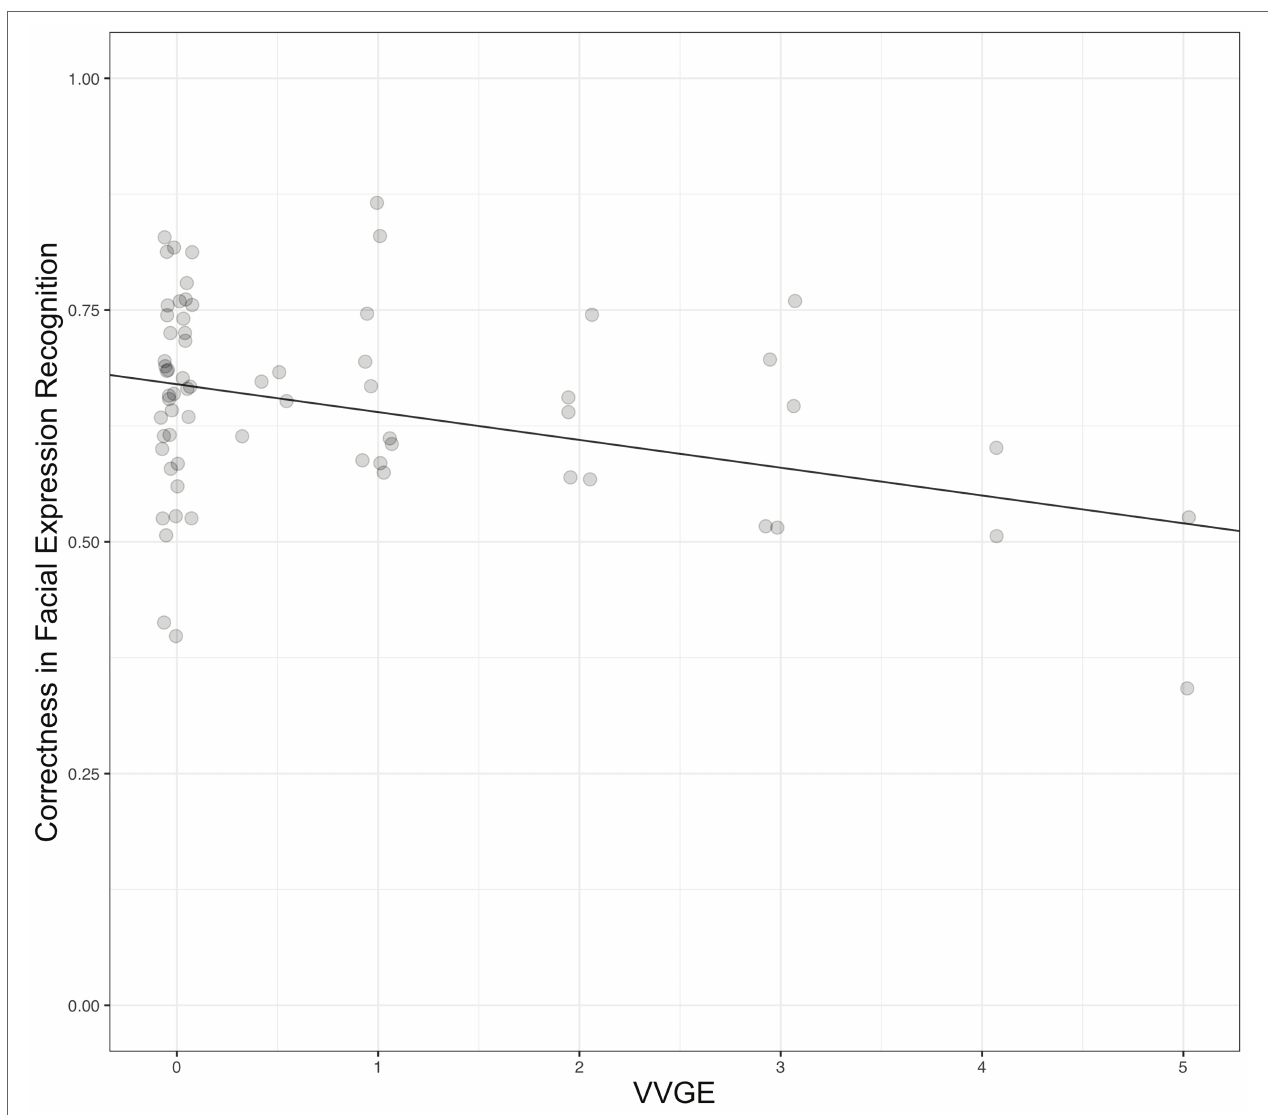
FIGURE 2 | The relationship between violent video game exposure (VVGE; in hours per day) and correctness in recognition of facial expressions of negative emotions (FEMT; 1.00 = 100% correctness) in Study 1. The value VVGE = 0 represents non-violent gamers and participant who did not play any games, whereas the values VVGE > 0 represent players of violent games, N =